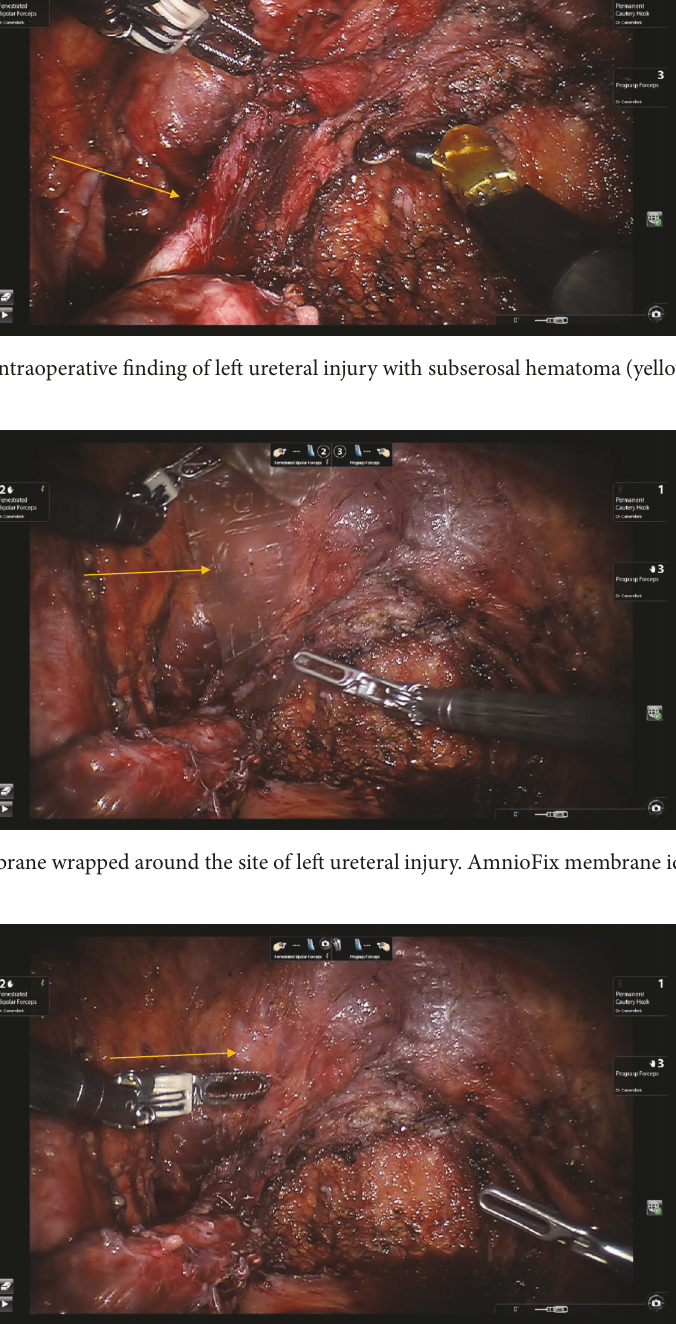
not be delineated. A guidewire was passed through the left ureter and into left renal pelvis without resistance and a left ureteral stent was placed. Her pain improved, and she was discharged